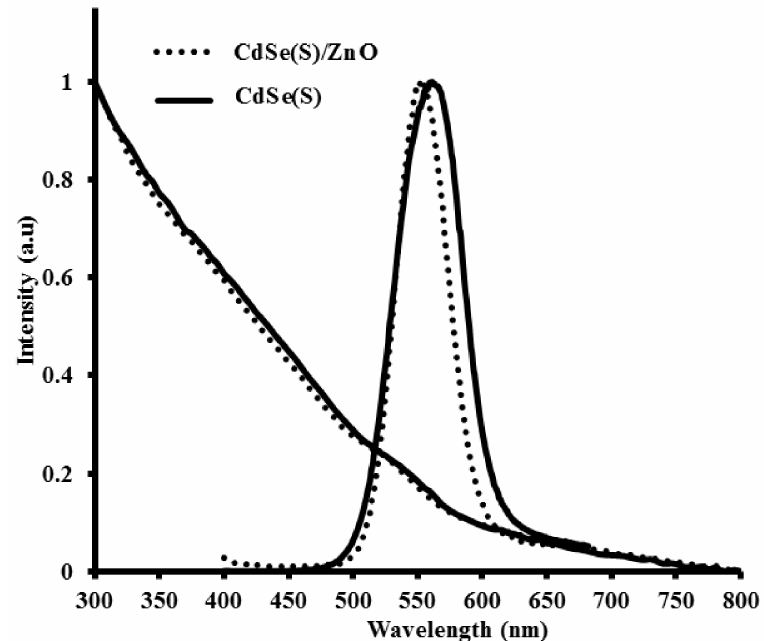
Figure 3. Optical spectra of CdSe(S) and CdSe(S)/ZnO